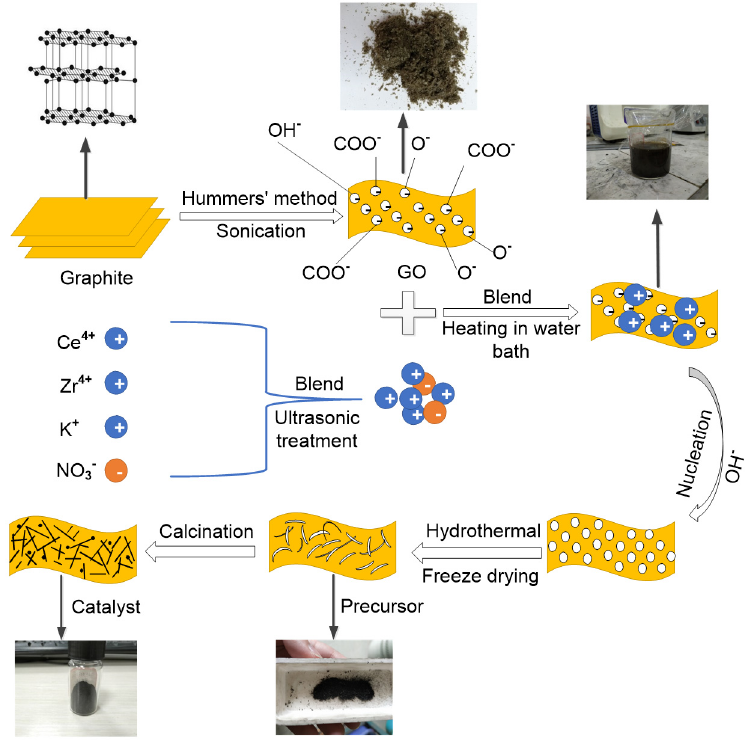
Figure 1. Schematic diagram of CeZrK/rGO catalysts preparation.